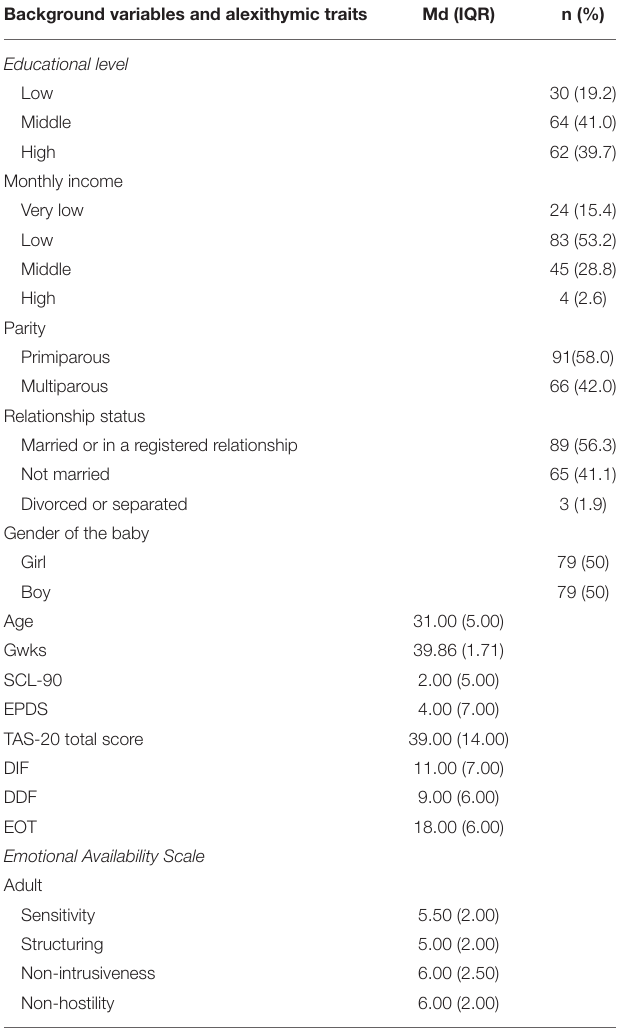
TABLE 1 | Descriptive statistics of maternal characteristics and alexithymic traits measured with the 20-item Toronto Alexithymia Scale (TAS-20) as well as mother-infant interaction measured with the Emotional Availability